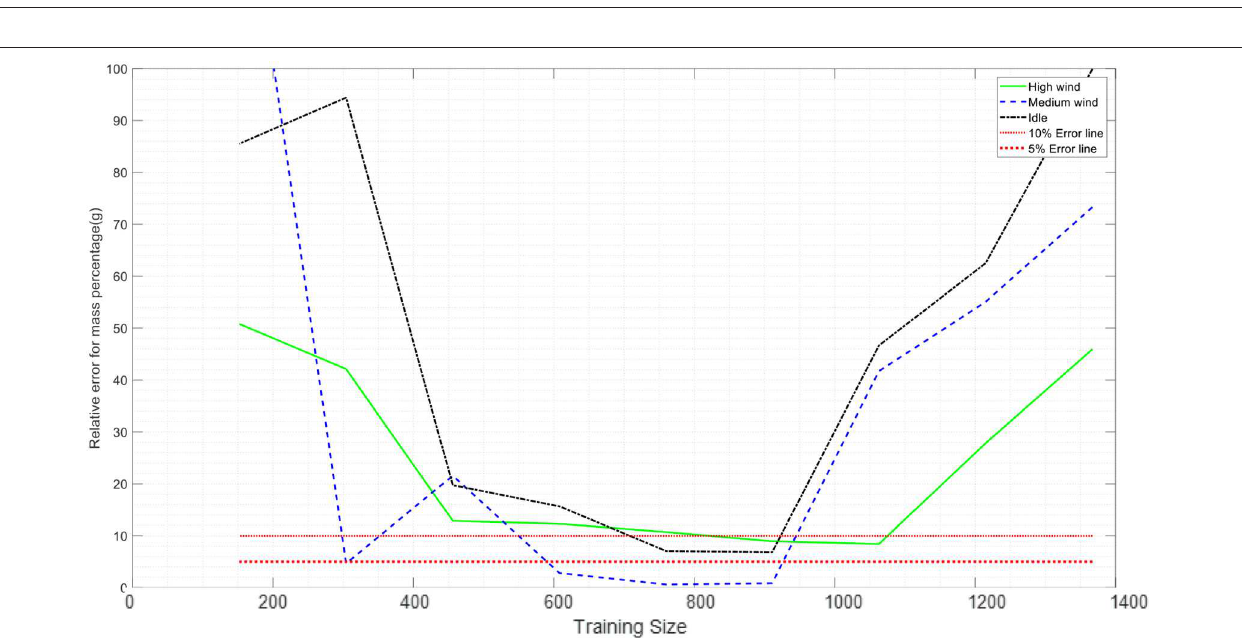
FIGURE 9 | Variation predication of firebrands’ mass and projected area correlation with sample size.